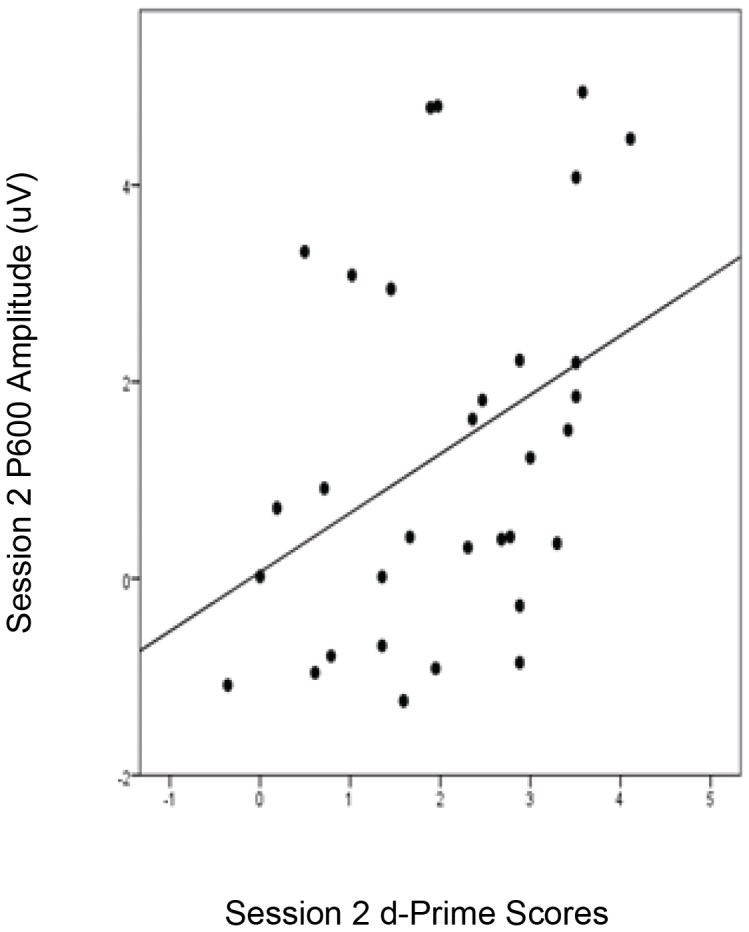
Relationship between ERP Results and Behavioural Performance.Scatter plot showing the correlation between behavioural measures of grammatical sensitivity (d-prime scores) at session 2 and P600 effects (mean amplitude of P600 difference wave at electrode Pz between 500–950 ms).